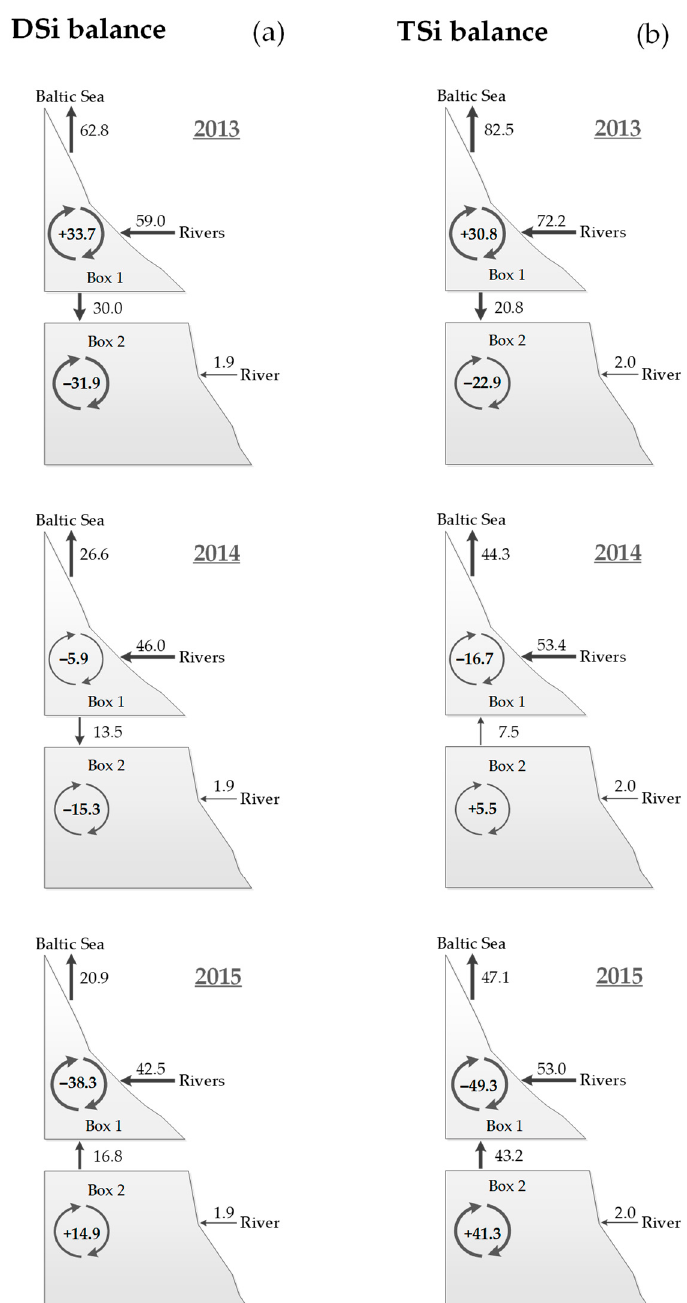
Figure 5. Dissolved inorganic (DSi) ( a ) and total silica (TSi) ( b ) budget for the Curonian Lagoon in 2013–2015. Legends are the same of Figure 3. Units are 10 5 mol d − 1